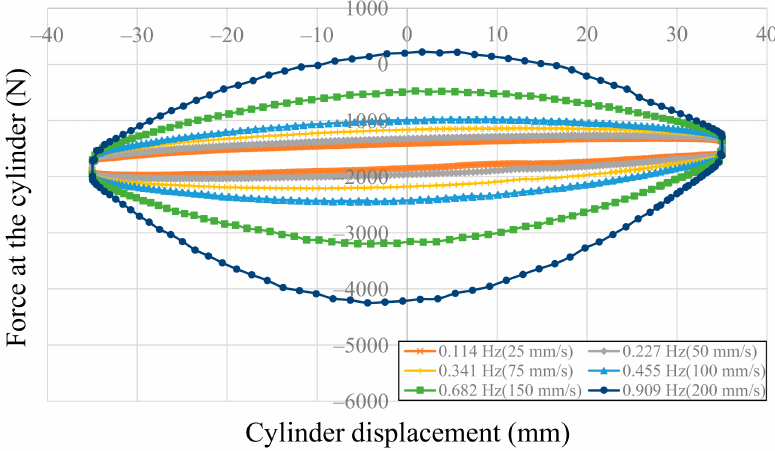
Figure 11. Force-velocity results from test when applied valve current was 900 mA (command